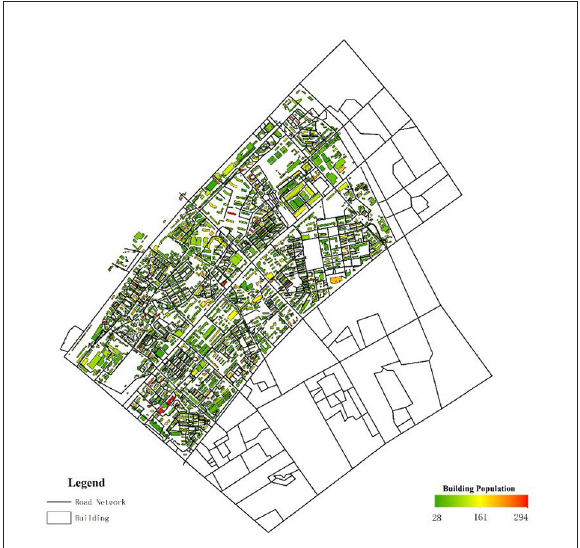
FIGURE9 The population distribution of each building.